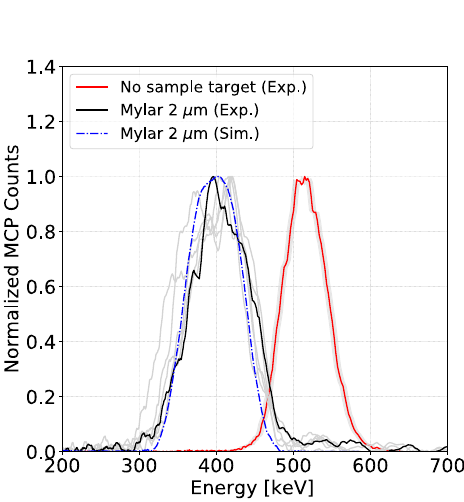
Figure 6. The experimental initial proton spectrum (red curve) and the downshifted proton spectrum after passing through 2 µ m Mylar coated with 40 nm Aluminum (black curve). The additional spectra (grey curves) are shown to demonstrate the repetitive behaviour. The simulated downshifted spectrum (dashed blue curve) is obtained with FLUKA MC